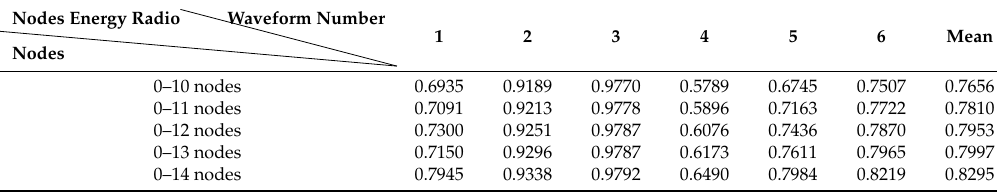
Figure 10. The WPT node energy distribution with different fault levels. Table 3. Nodes energy ratio.